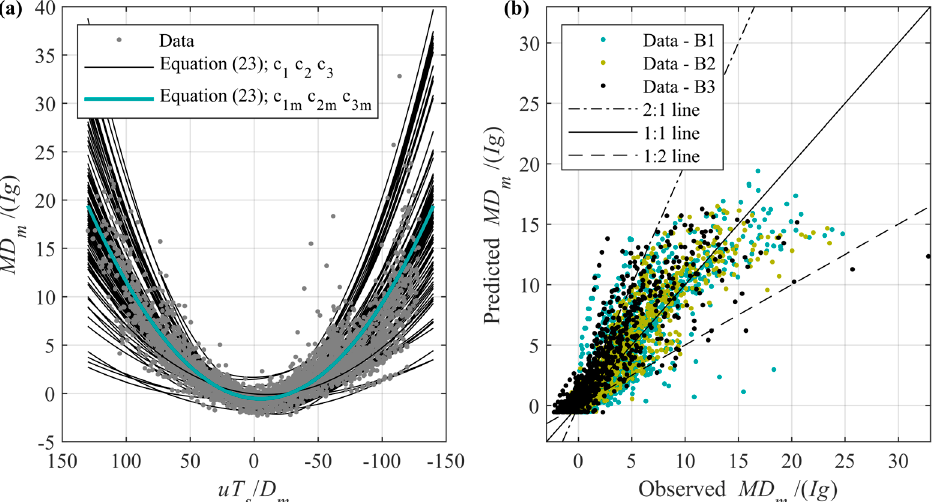
Figure 7. ( a ) Moment—cross-shore flow velocity relationship; observed data (gray circles), Equation (23) fitted for each event (black lines) and Equation (23) with mean coefficients c 1m , c 2m, and c 3m (blue line). ( b ) Comparison between observed and predicted moment dimensionless group using Equation (23) with mean coefficients. Table 4. Statistics of the coefficients c 1 , c 2, and c 3 (Equation (23)).